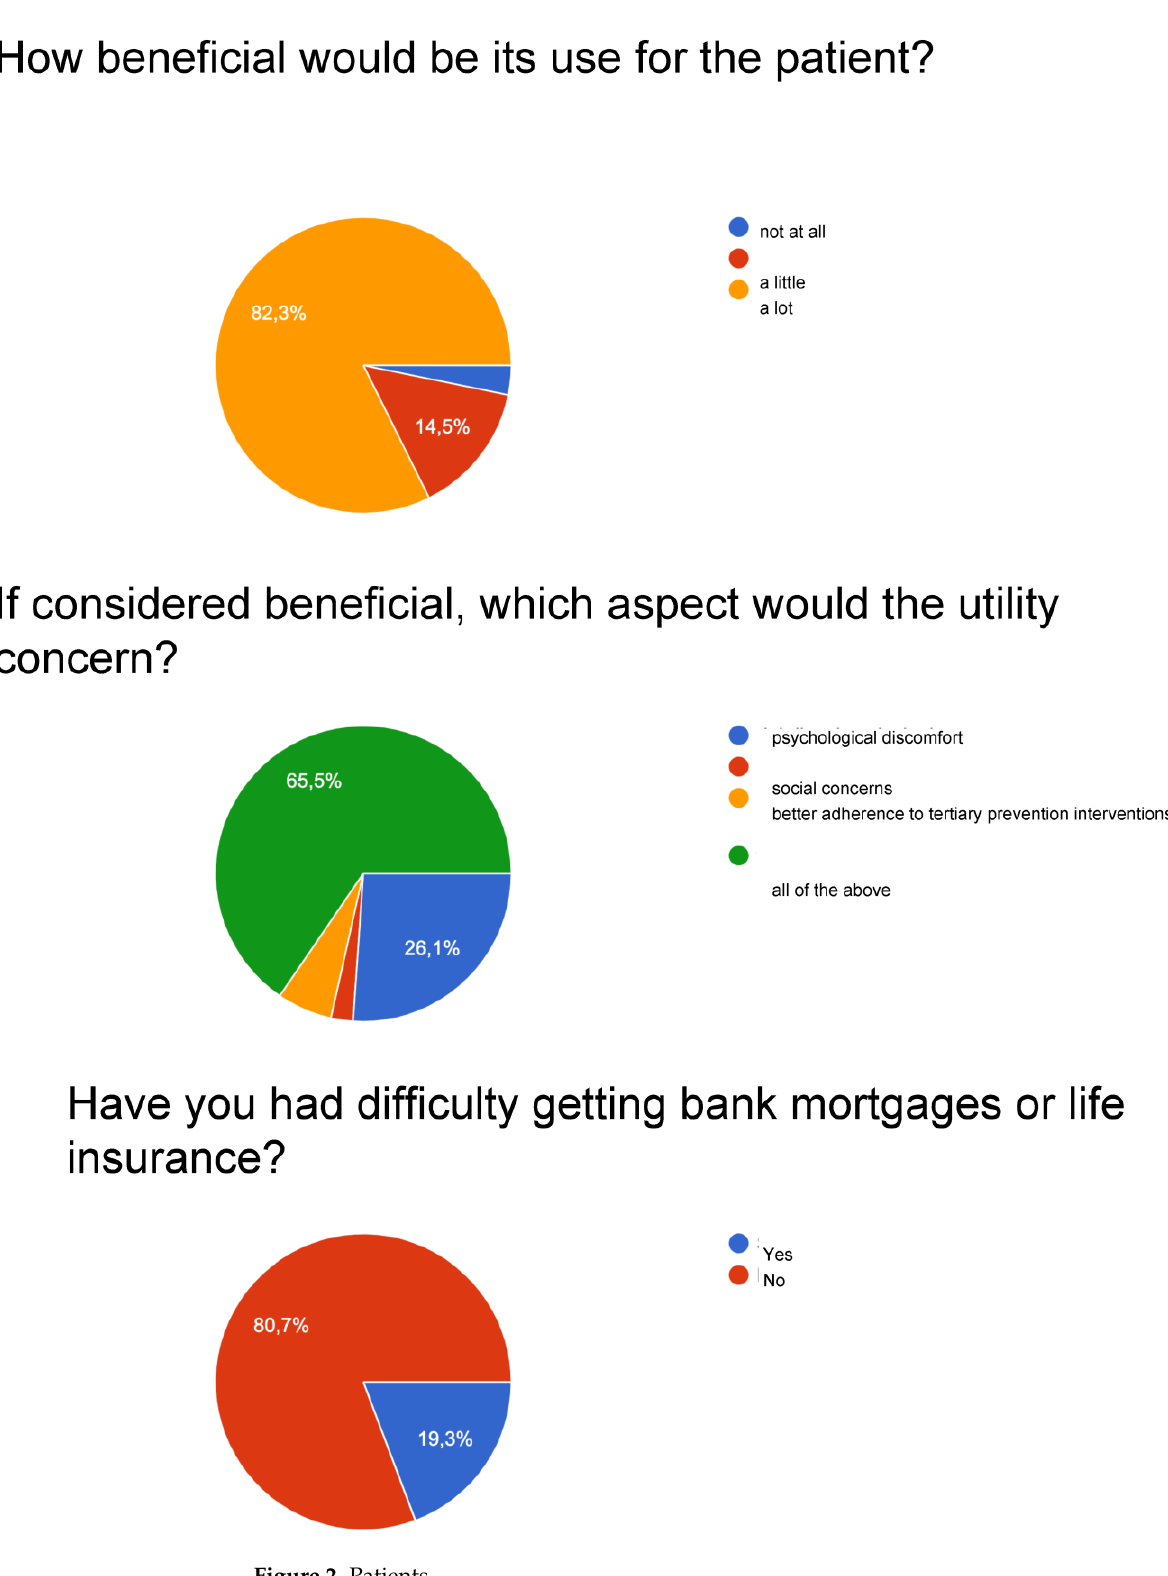
Figure 2. Patients. Figure 2.